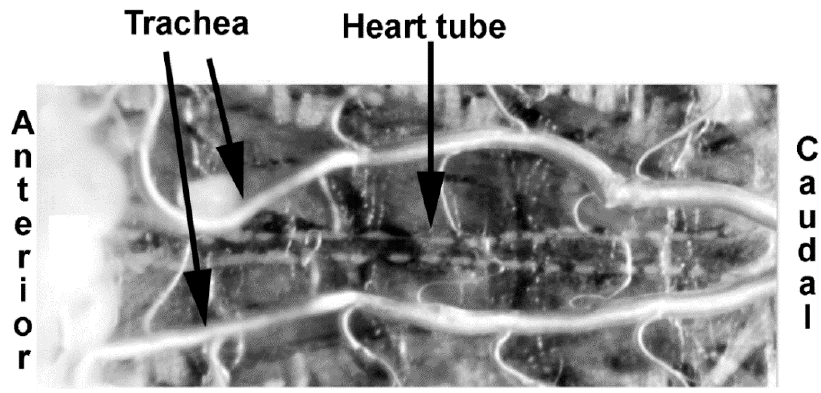
Figure 1. Ventral dissection representation of a third instar larva.